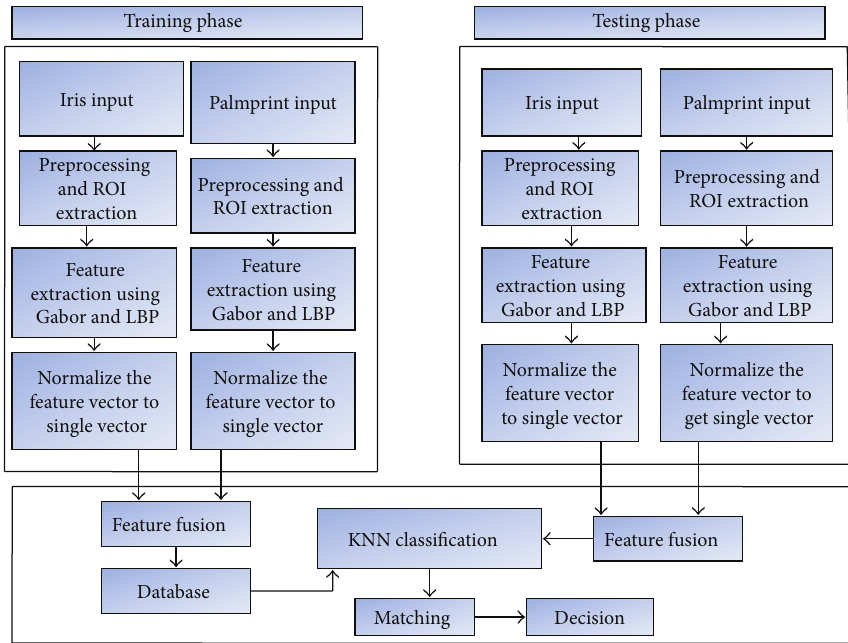
Figure 5: Proposed feature fusion multimodal biometric